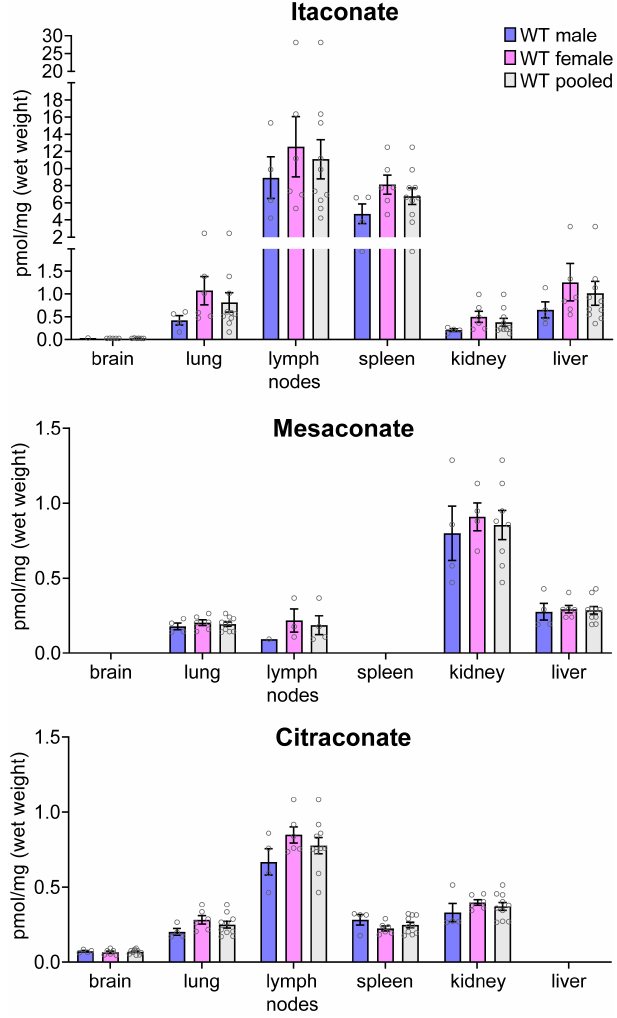
Figure 3. Itaconate, mesaconate, and citraconate concentrations in extracted mouse organs of 44 to 46 weeks old C57BL/6J wild-type (WT) mice. Itaconate was most abundant in organs related to the immune system while mesaconate was enriched in organs responsible for metabolism and secretion/excretion. Citraconate was also highest in lymph nodes and was the only isomer that could be quantified in brain; n = 4 male and n = 6 female mice; mean considered missing values.